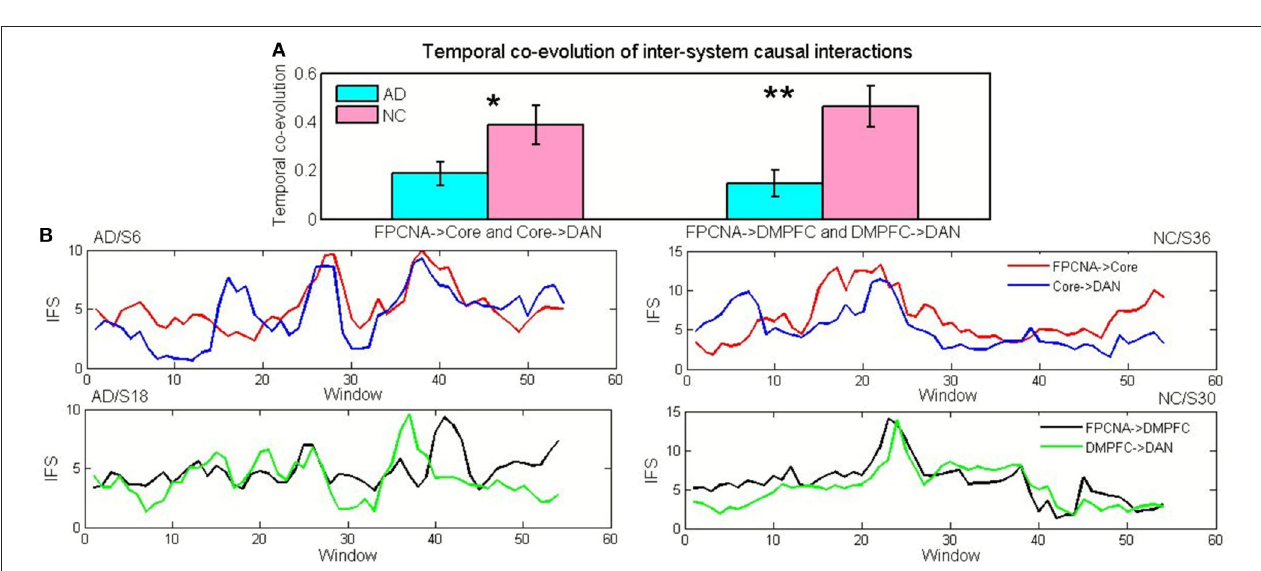
FIGURE 6 | The correlation of forward and feedback IFS between the FPCNA and three DN subsystems in the NC and AD groups.